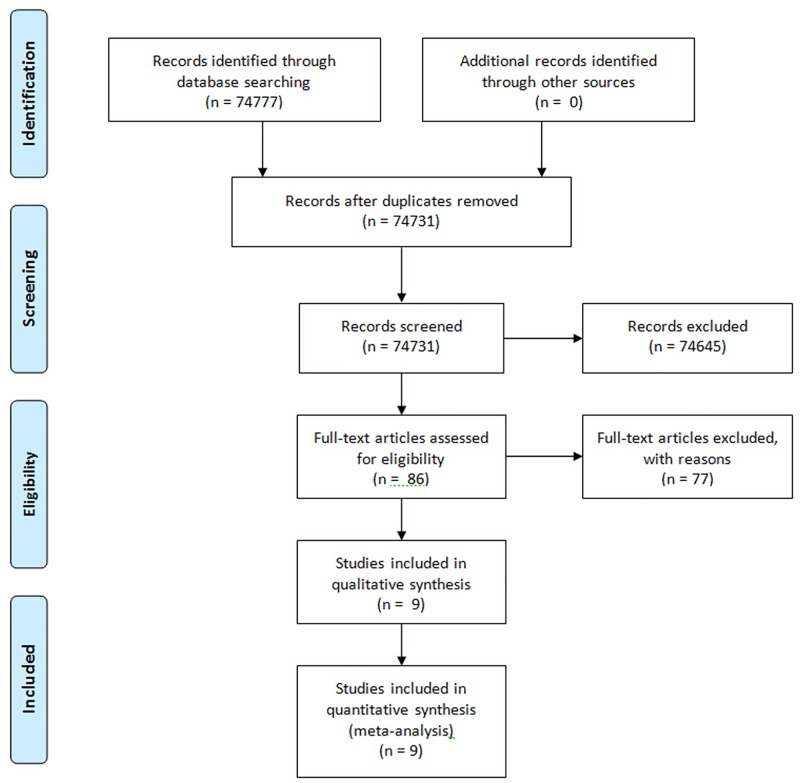
Search flow diagram for retrieving relevant studies.